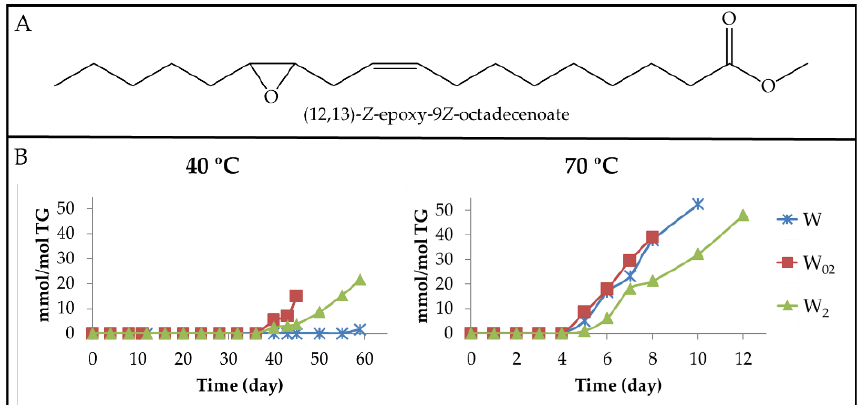
Figure 17. ( A ) Structure of (12,13)- Z -epoxy-9 Z -octadecenoate as an example of Z -mEPO- Z -mE. ( B ) Evolution of the concentration expressed as mmol/mol TG, of Z -mEPO- Z -mEs plus Z -mEPO- Z -dEs present in walnut oil having different enrichment levels in αT (W, W 02 and W 2 ), submitted to either 40 °C or 70 °C up to advanced stages of the oxidation process.